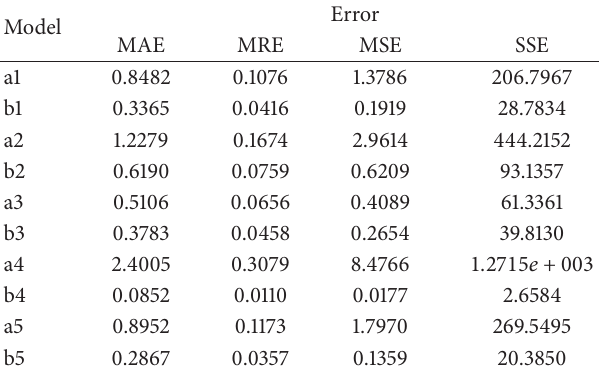
Table 6: Different wind speed model